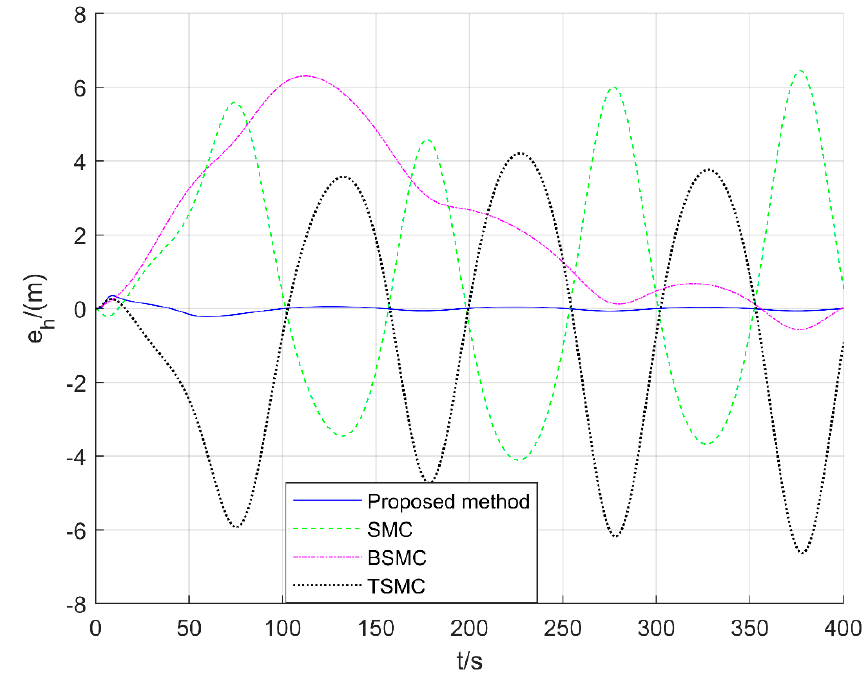
Figure 8. Responses of altitude tracking.